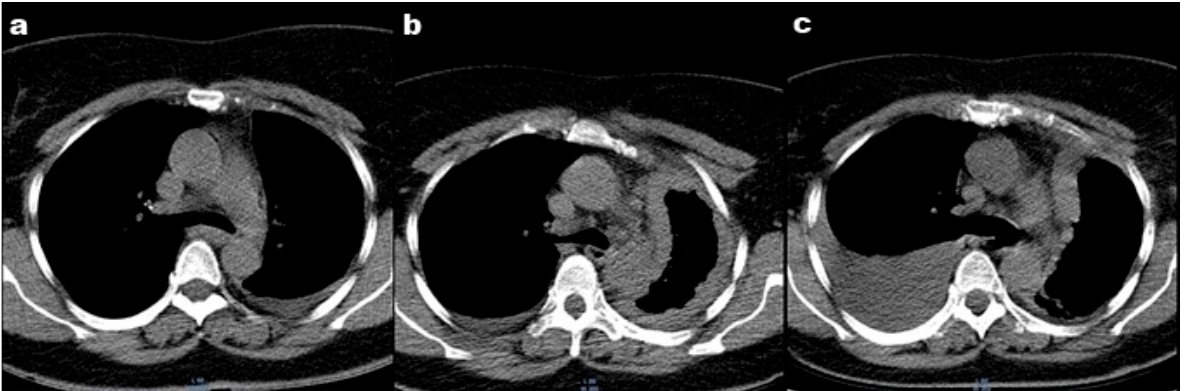
Figure 1. Thoracic computed tomography: ( a ) Thoracic CT performed in 2019 showing pleural effusion in the left hemithorax; ( b ) Thoracic CT performed in 2021 showing pleural effusion in the left hemithorax; ( c ) Thoracic CT performed in 2022 showing right pleural effusion. Between 2019 and 2021, the dyspnea progressively accentuated, and it was accompa- nied by chest pain and weight